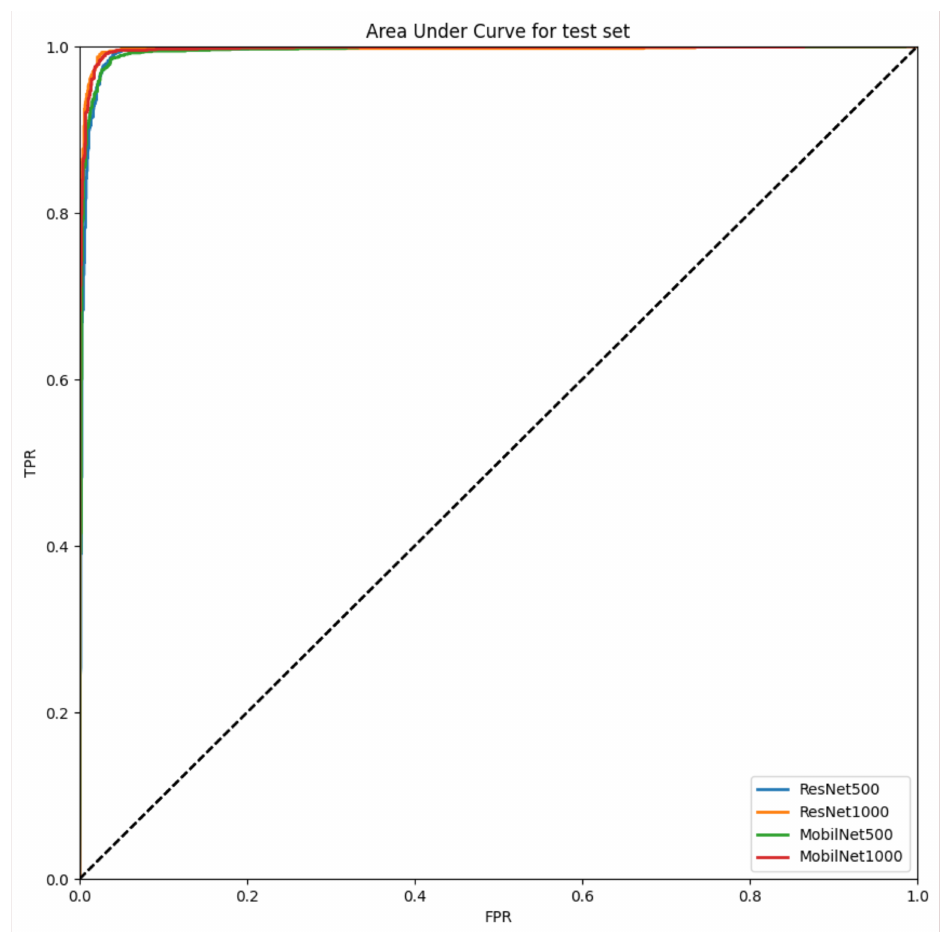
Figure 4. Area Under the Receiver-Operating-Characteristic Curve for the Test Set. Note: TPR True Positive Rate (Sensitivity), FPR False Positive Rate (1—Specificity).